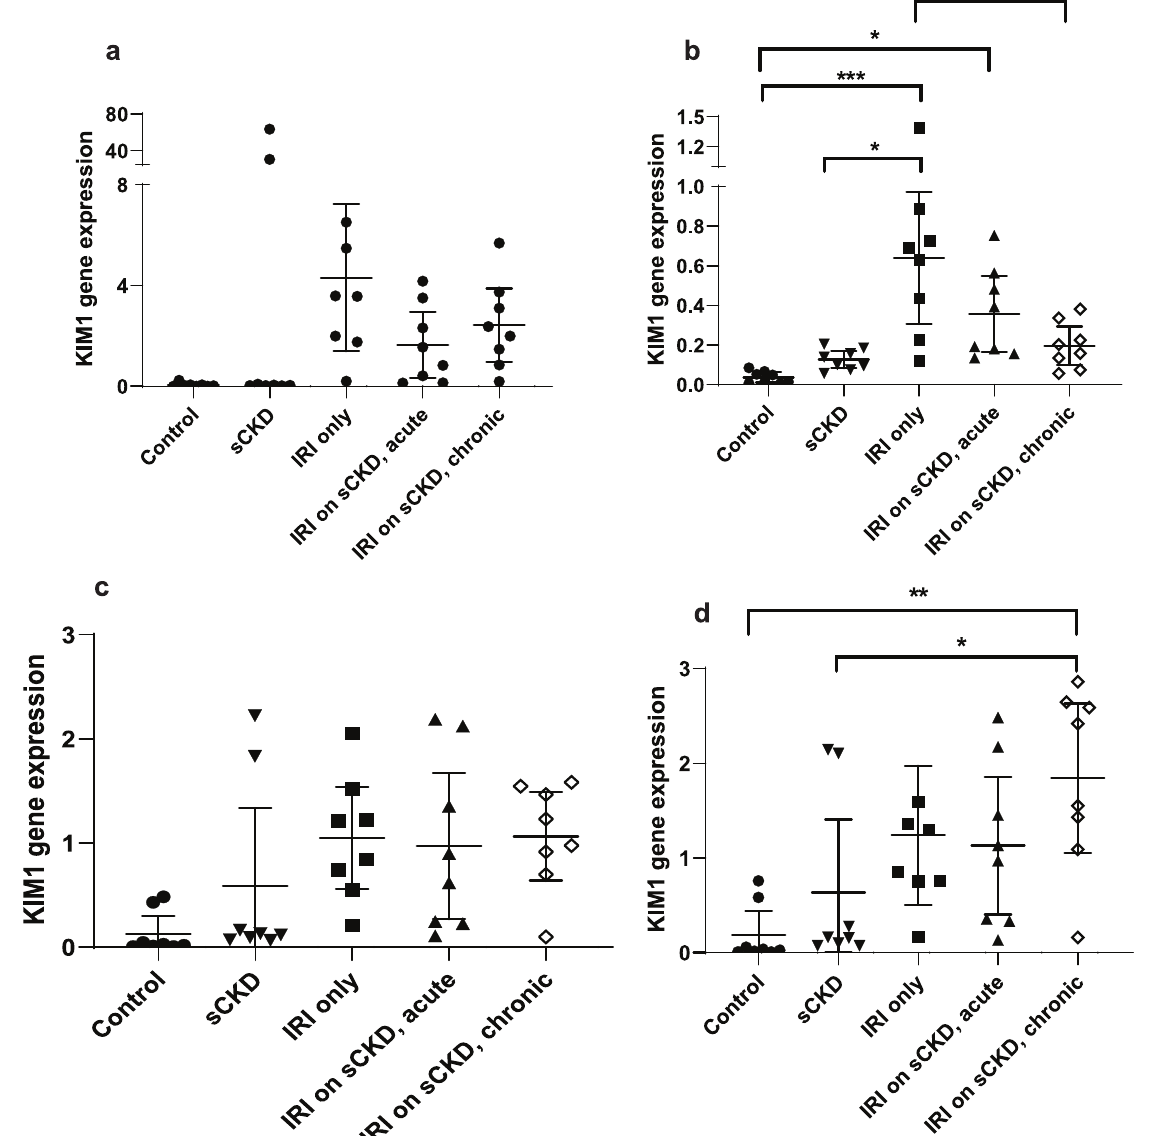
Fig 3. Expression of KIM-1 normalised to a) 18S , b) GAPDH , c) PABPN1×HMBS , d) ACTB×PABPN1 in the IRI treated groups. Data are means (one-way ANOVA) or medians (Kruskal Wallis) and 95% CI (n � 6). � p < 0.05, �� p < 0.01, ��� p <